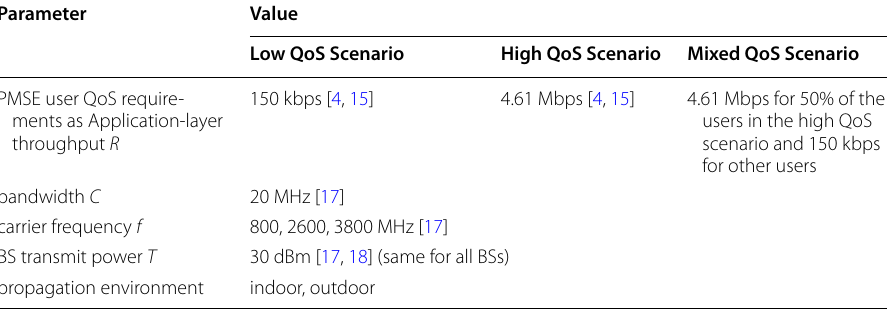
Table 1 PMSE user QoS requirements and technical parameters Parameter